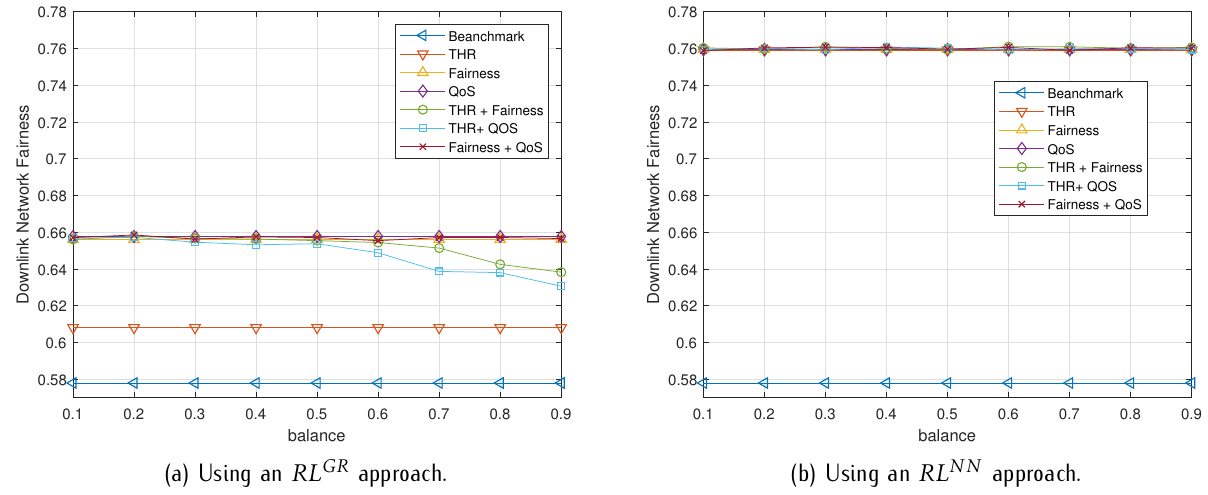
Figure 3. Percentage of downlink throughput fairness respect to the F